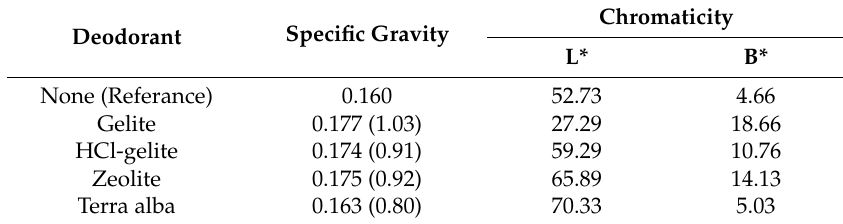
Figure 5. Photo images of the forms over-coated by the deodorants. ( A ) Reference ( B ) Gelite ( C ) HCl-gelite ( D ) Zeolite ( E ) Terra alba. Table 1. Specific gravity and chromaticity of the foams over-coated by the deodorants. L*: lightness, b*: